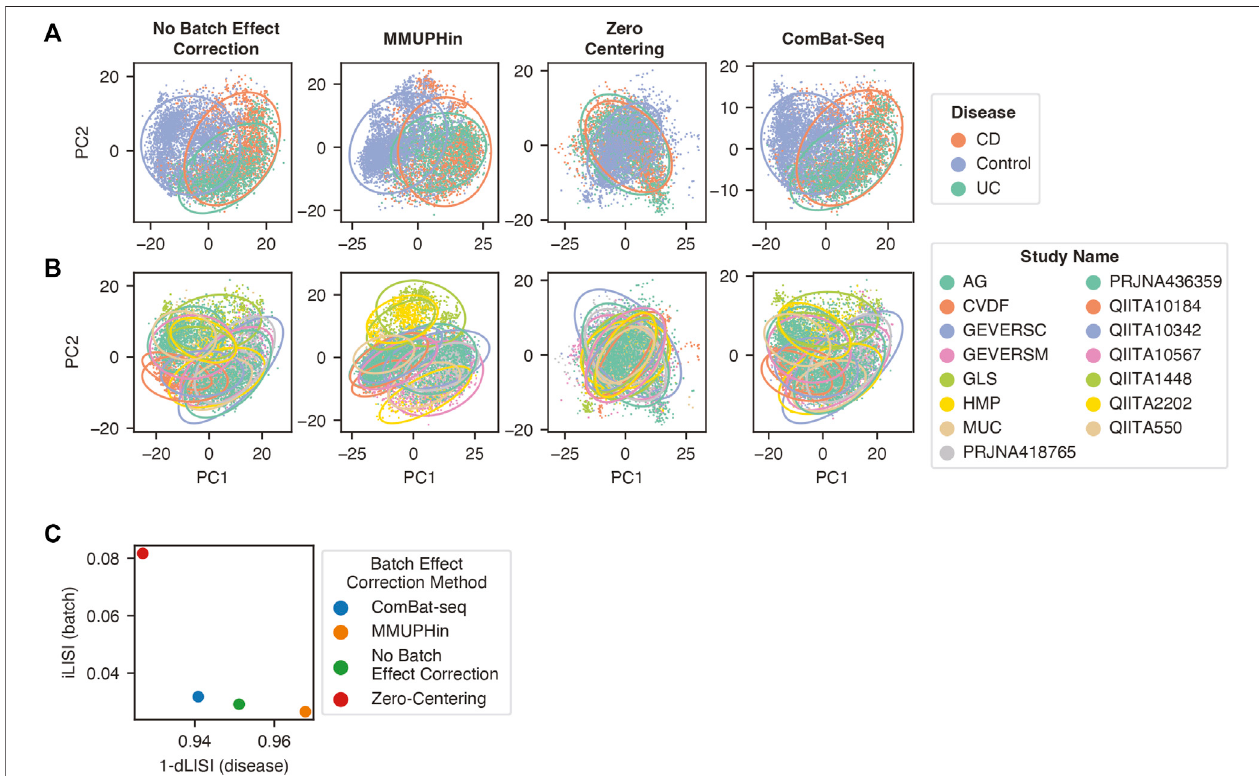
FIGURE5| Batcheffectcorrectionbyzero-centering,MMUPHin,andComBat-seq.PrincipalcomponentanalysisofgenusfeaturesfollowCLRtransformationand batch effect correction with the points coloured by disease label (A) or study label (B) . The 95% con fi dence ellipse for each category within the label is shown to better visualize the mixing and separation of different labels. (C) The normalized median LISI value for the batch label ( y -axis) and the 1-normalized median LISI value for the disease label ( x -axis).